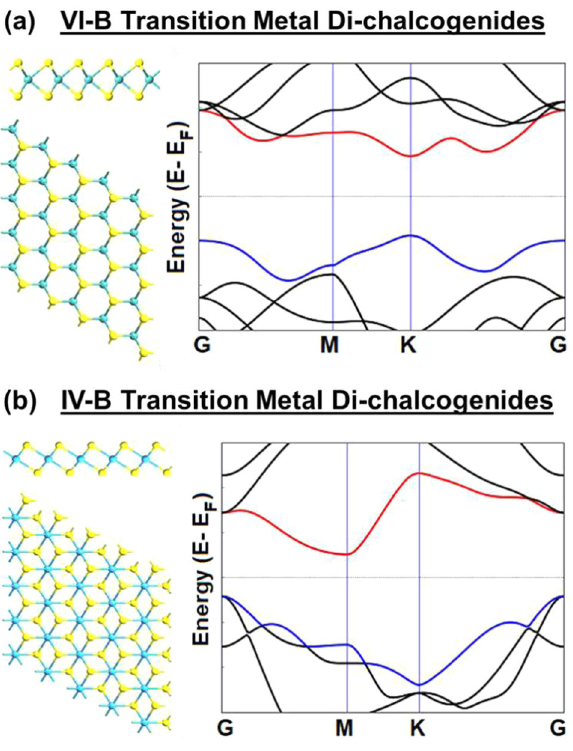
Fig. 11 Structure and Electronic Properties of TMDs. The side-view and top view representations (5 × 5 × 1 Supercell) of the monolayer a Group-VIB and b Group IVB TMDC and their energy-crystal wave vector (E-k) dispersion relations where the conduction band and valance band are marked in red and blue,